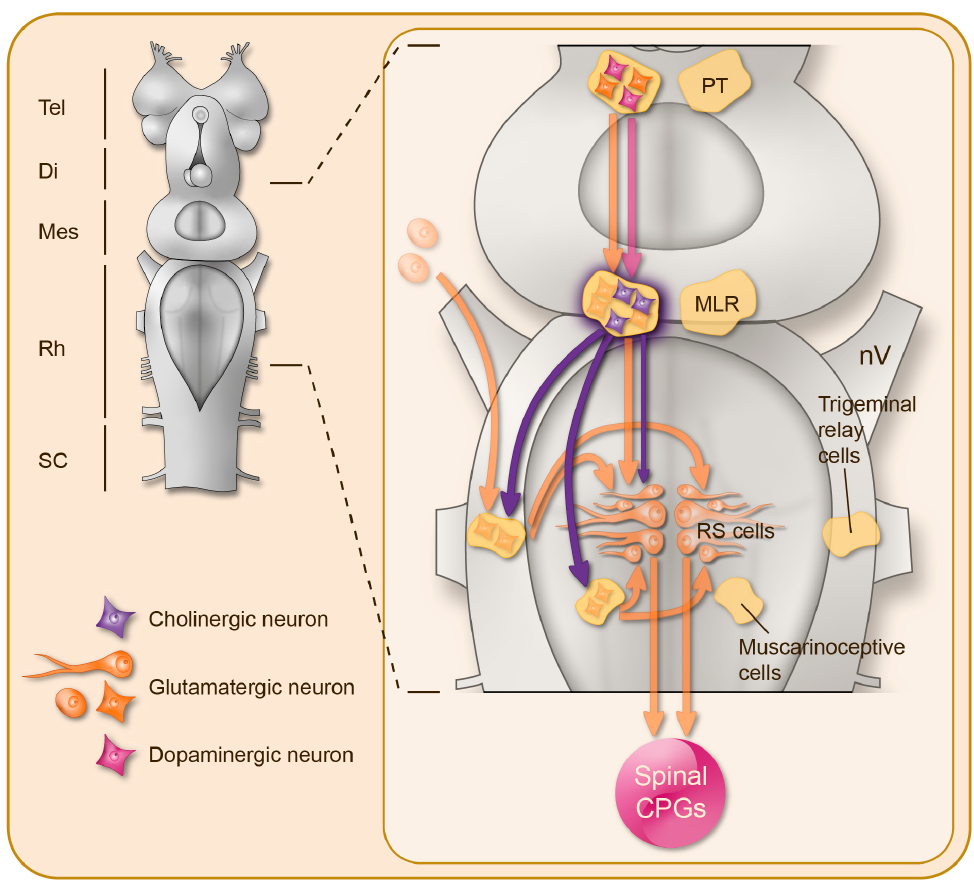
Figure 1. Cholinergic control of the reticulospinal neurons in the lamprey brainstem. Right : Schematic representation of the lamprey CNS, illustrating from top to bottom: the forebrain (Tel: telencephalon; Di: diencephalon), the brainstem (Mes: mesencephalon; Rh: rhombencephalon), and the spinal cord (SC). Left : Magnification of the brainstem illustrating the distribution of the cholinergic neurons (purple) and their projections. Under the control of glutamatergic (orange) and dopaminergic (pink) descending inputs from the posterior tuberculum, the mesencephalic locomotor region exerts glutamatergic and nicotinic cholinergic excitation on the reticulospinal (RS) neurons that in turn activate the downstream spinal central pattern generators for locomotion (CPGs). There is also a muscarinic cholinergic neuromodulation onto a population of excitatory ponto-medullary muscarinoceptive neurons, which in turn boost the reticulospinal neuron activation, and onto the trigeminal relay cells in order to filter the sensory inputs conveyed by the trigeminal nerves (nV) to the reticulospinal